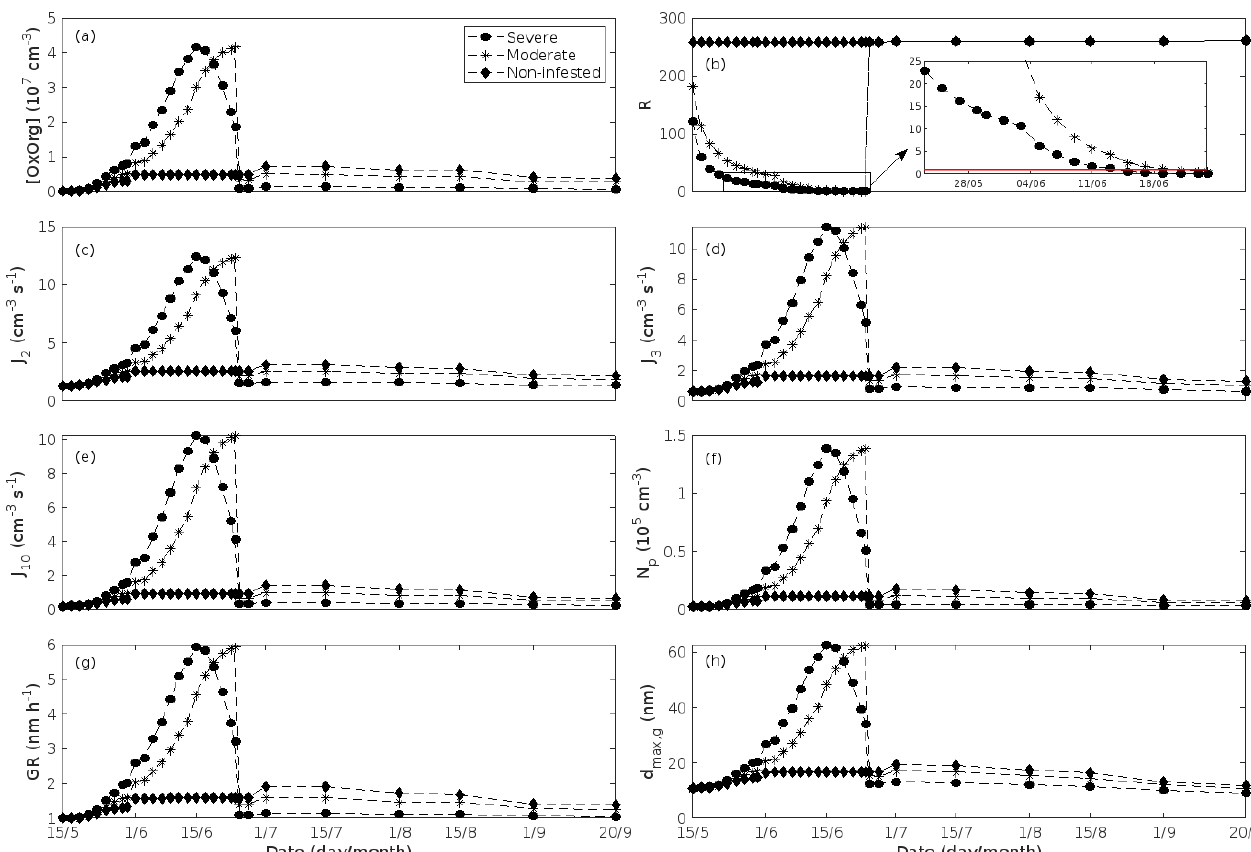
Figure 6. A pure oak stand infested with European gypsy moth larvae in comparison to a non-infested pure oak stand. (a) Atmospheric concentrations of OxOrg. (b) The ratios of isoprene-to-monoterpenes carbon concentrations, where the red line indicates R = 1. Formation rates of (c) 2, (d) 3, and (e) 10nm particles. (f) Number concentrations of formed particles, (g) growth rates of newly formed particles, and (h) the daily maxima diameter of the growing particle mode. “Moderately” and “severely” refer to 30% and 80%, respectively, of the leaf area that has been consumed by the end of the feeding